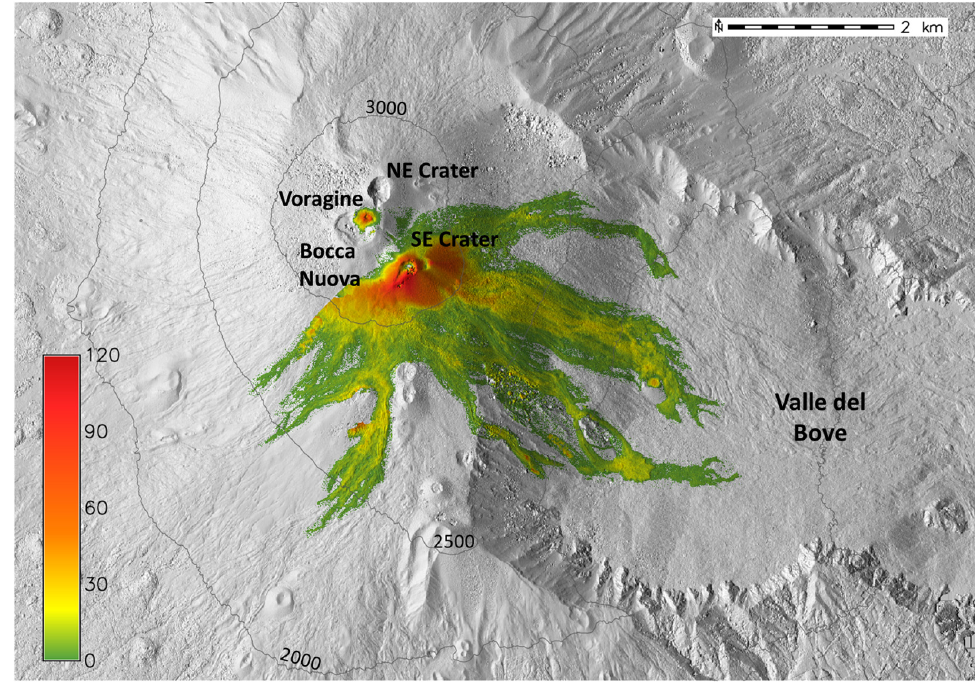
Figure 5. Elevation difference in meters between the 2021 and 2016 Digital Surface Models.